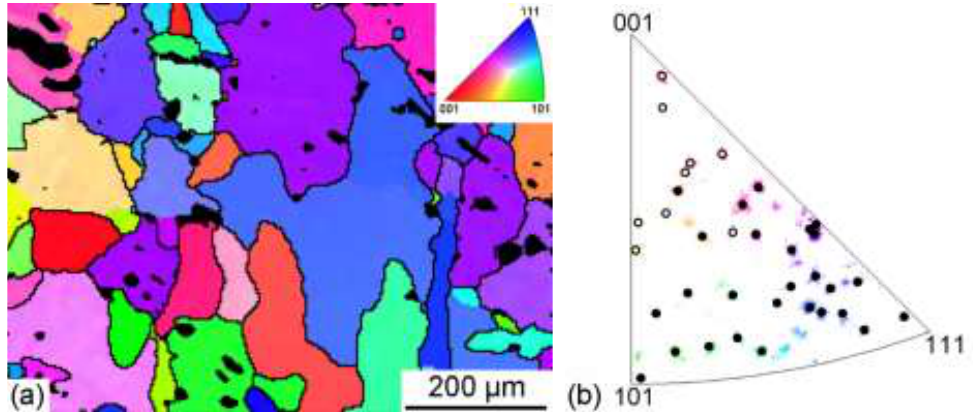
Figure 4. EBSD orientation maps ( a ) and IPF ( b ) of grains detected in the initial sample after 30 days of immersion testing. Note that the black regions in ( a ) are the preferentially corroded sites which cannot be resolved by EBSD. The grains without corroded sites are marked as hollow circles while the grains with corroded sites are marked as solid black circles in ( b ).